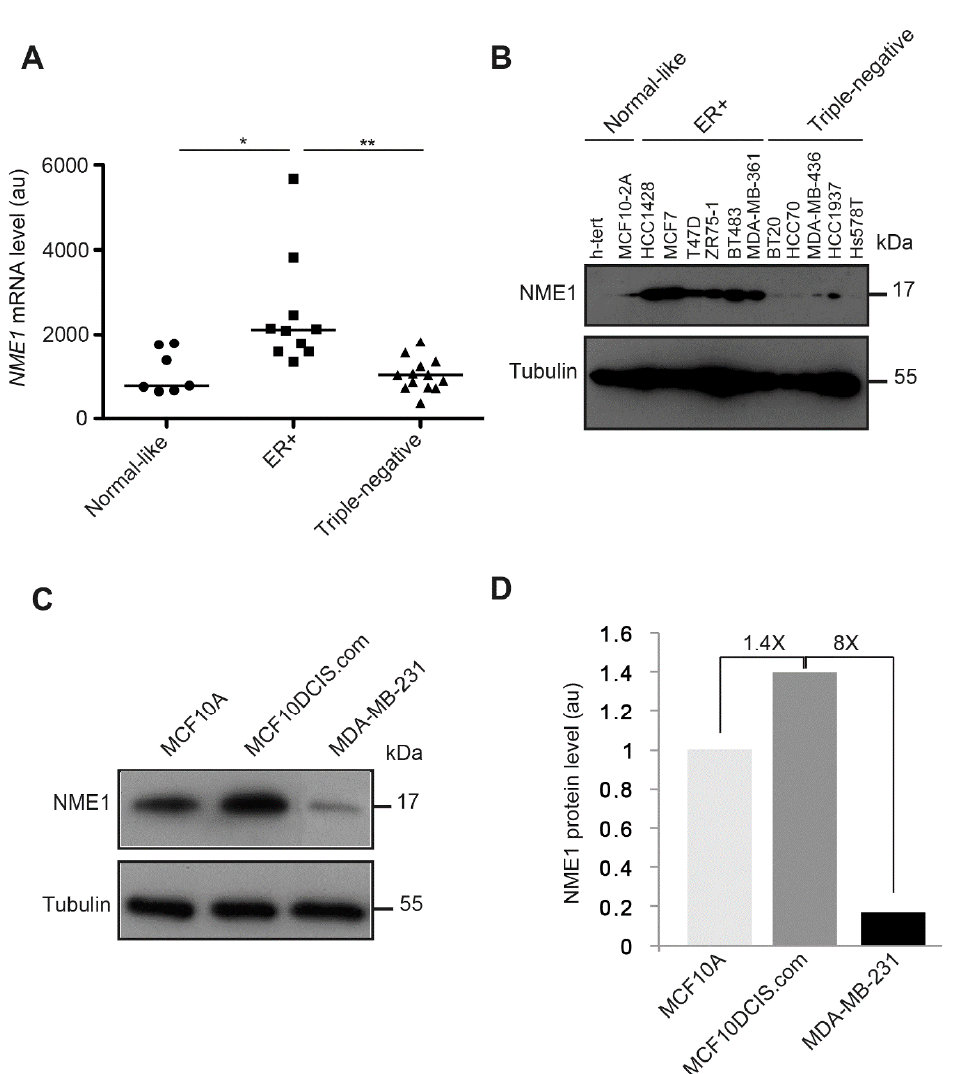
Figure 9. NME1 expression is reduced in human breast tumor cell lines with the triple-negative phenotype. ( A ) NME1 mRNA levels were measured by RT–qPCR in normal-like human breast cell lines, in estrogen receptor-positive (ER+) human breast tumor cell lines, and in triple-negative human breast tumor cell lines. Each data point represents one cell line. Three independent analyses were performed for each cell line. Data are expressed as means ± SEM. ** p < 0.01, * p < 0.05. ( B ) NME1 protein levels were analyzed by Western blotting lysates of normal-like human breast cell lines (h-tert, MCF10-2A), ER+ human breast tumor cell lines (HCC1428, MCF7, T47D, ZR75-1, BT483, and MDA-MB-361) and triple-negative human breast tumor cell lines (BT20, HCC70, MDA-MB-436, HCC1937, and Hs578T). Equal loading was verified by Western blotting for tubulin. Molecular weights are indicated in kDa. ( C ) NME1 protein levels were analyzed by Western blotting lysates of the normal-like human breast cell line MCF10A, the epithelial-like human breast tumor cell line MCF10DCIS.com and the invasive mesenchymal human breast tumor cell line MDA-MB-231. Equal loading was verified by Western blotting for tubulin. Molecular weights are indicated in kDa. ( D ) Quantification of NME1 protein levels as observed in ( C ) in arbitrary unit